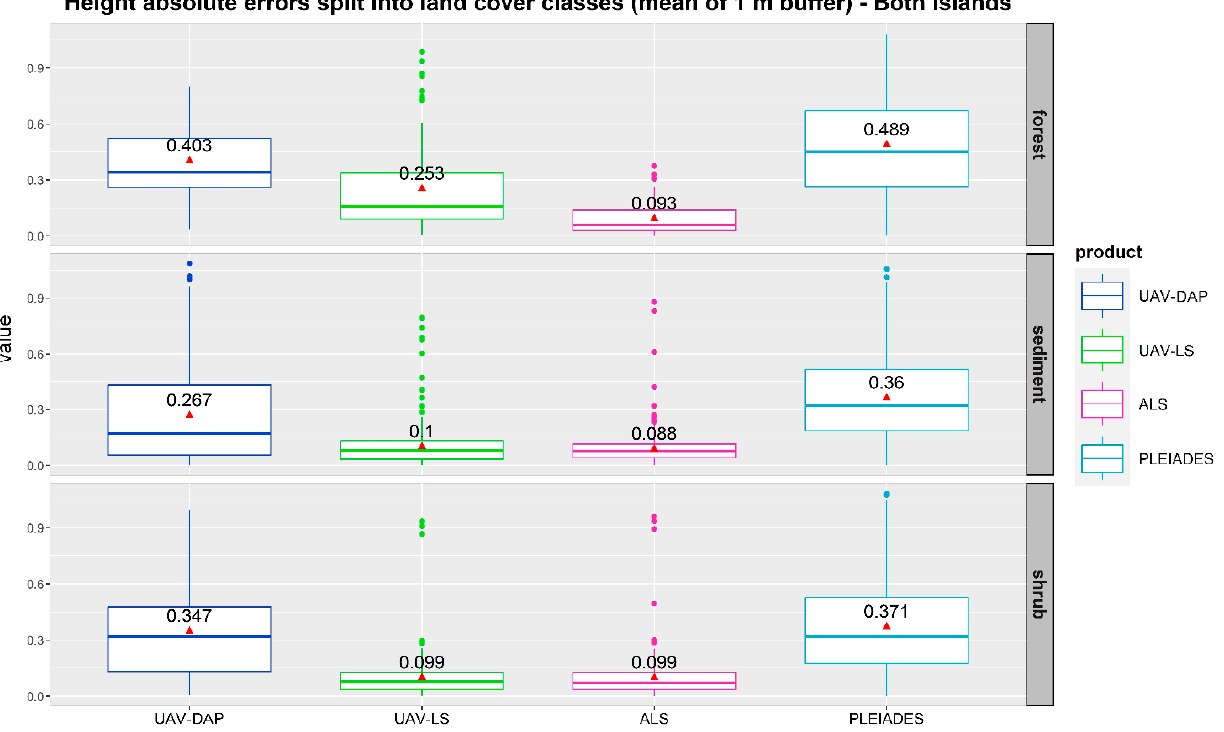
Figure 9. Accuracy of DTMs generated from data from di ff erent platforms and sensors, grouped by di ff erent land cover classes: unmanned aerial vehicle (LiDAR and DAP techniques), aircraft (ALS–LiDAR), and Pléiades satellite (DAP–RGB images).